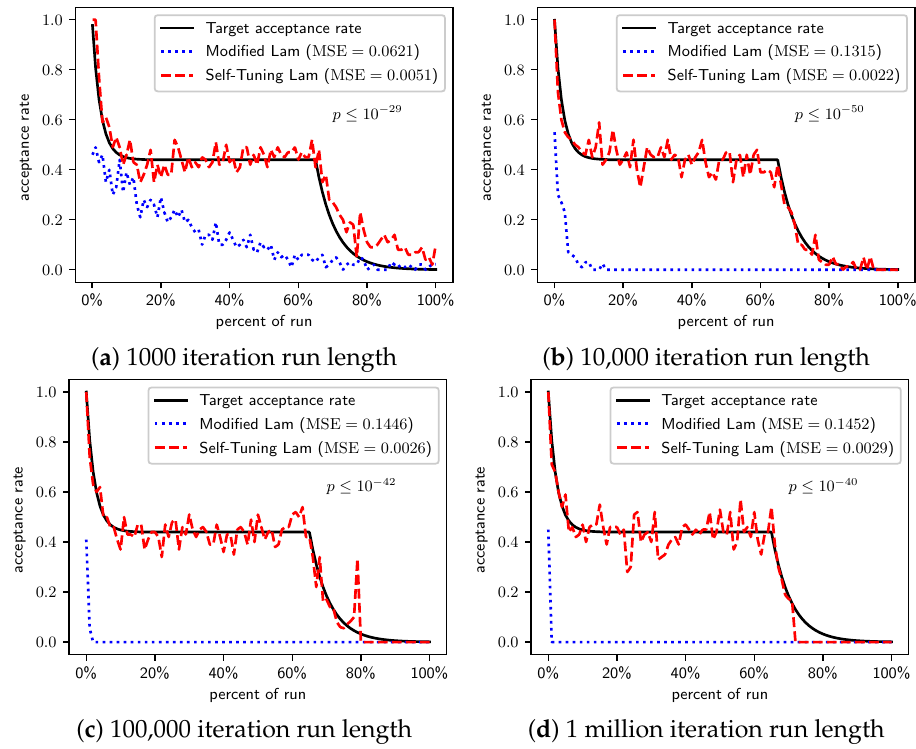
Figure 4. OneMax (each 0-bit costs 100): Self-Tuning Lam, Modified Lam, and target acceptance rates for ( a ) 1000 iterations, ( b ) 10,000 iterations, ( c ) 100,000 iterations, and ( d ) 1 million